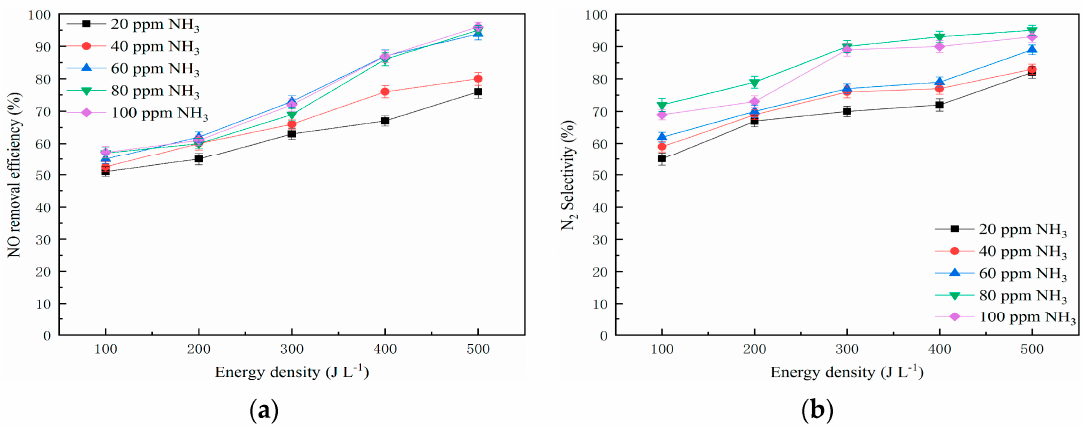
Figure 10. E ff ect of NH 3 concentration on NO removal e ffi ciency. ( a ) NO removal e ffi ciency and ( b ) N 2